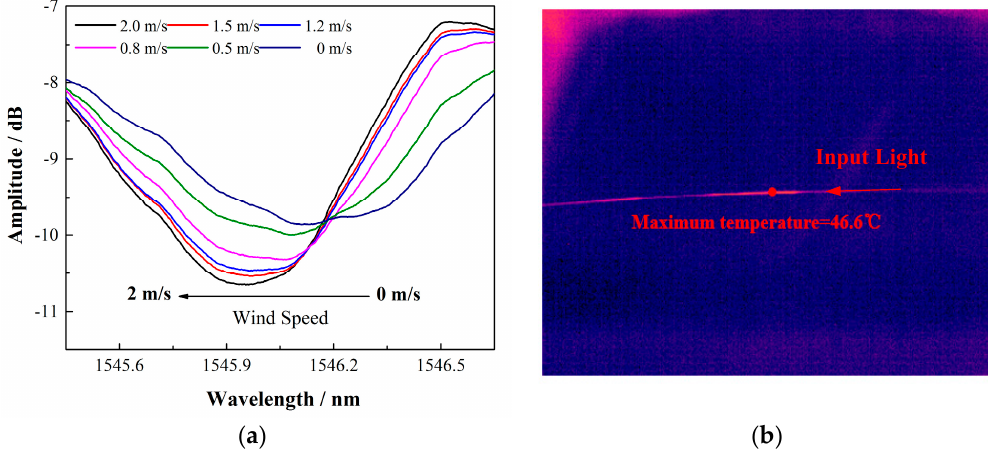
Figure 5. ( a ) The spectral response of one cladding mode under different wind speeds. Increasing the wind speed from 0 to 2 m/s results in a blue shift of the resonance from 1546.172 nm to 1545.952 nm. ( b ) The temperature distribution image detected by the MAG30 on-line thermal imager. The maximum temperature was measured up to be 46.6 °C when the input power was 22.97 mW.